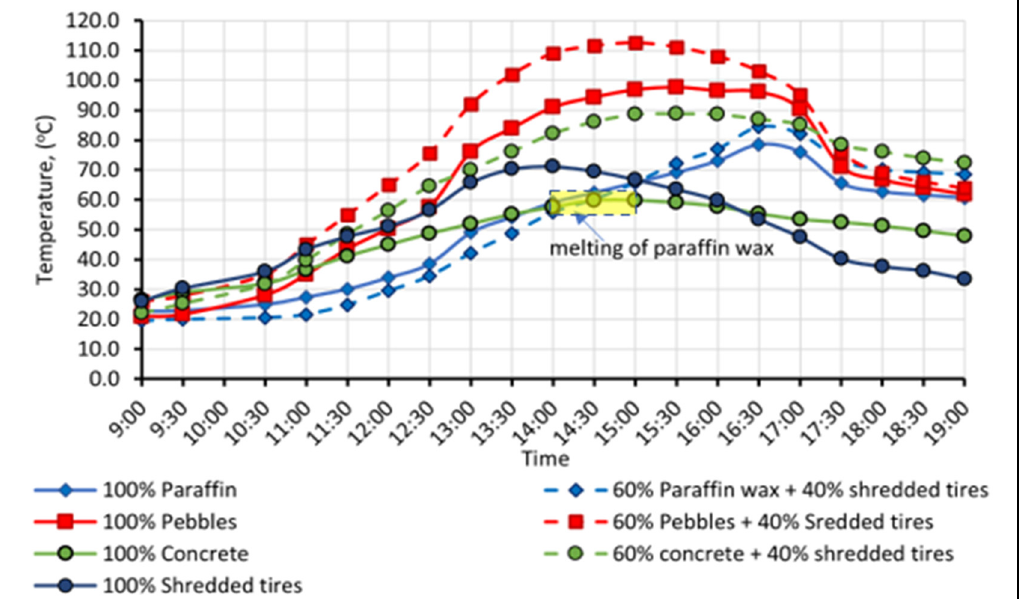
Figure 6. Measured temperature as the mean of five-day repeatability of the seven types of TES.